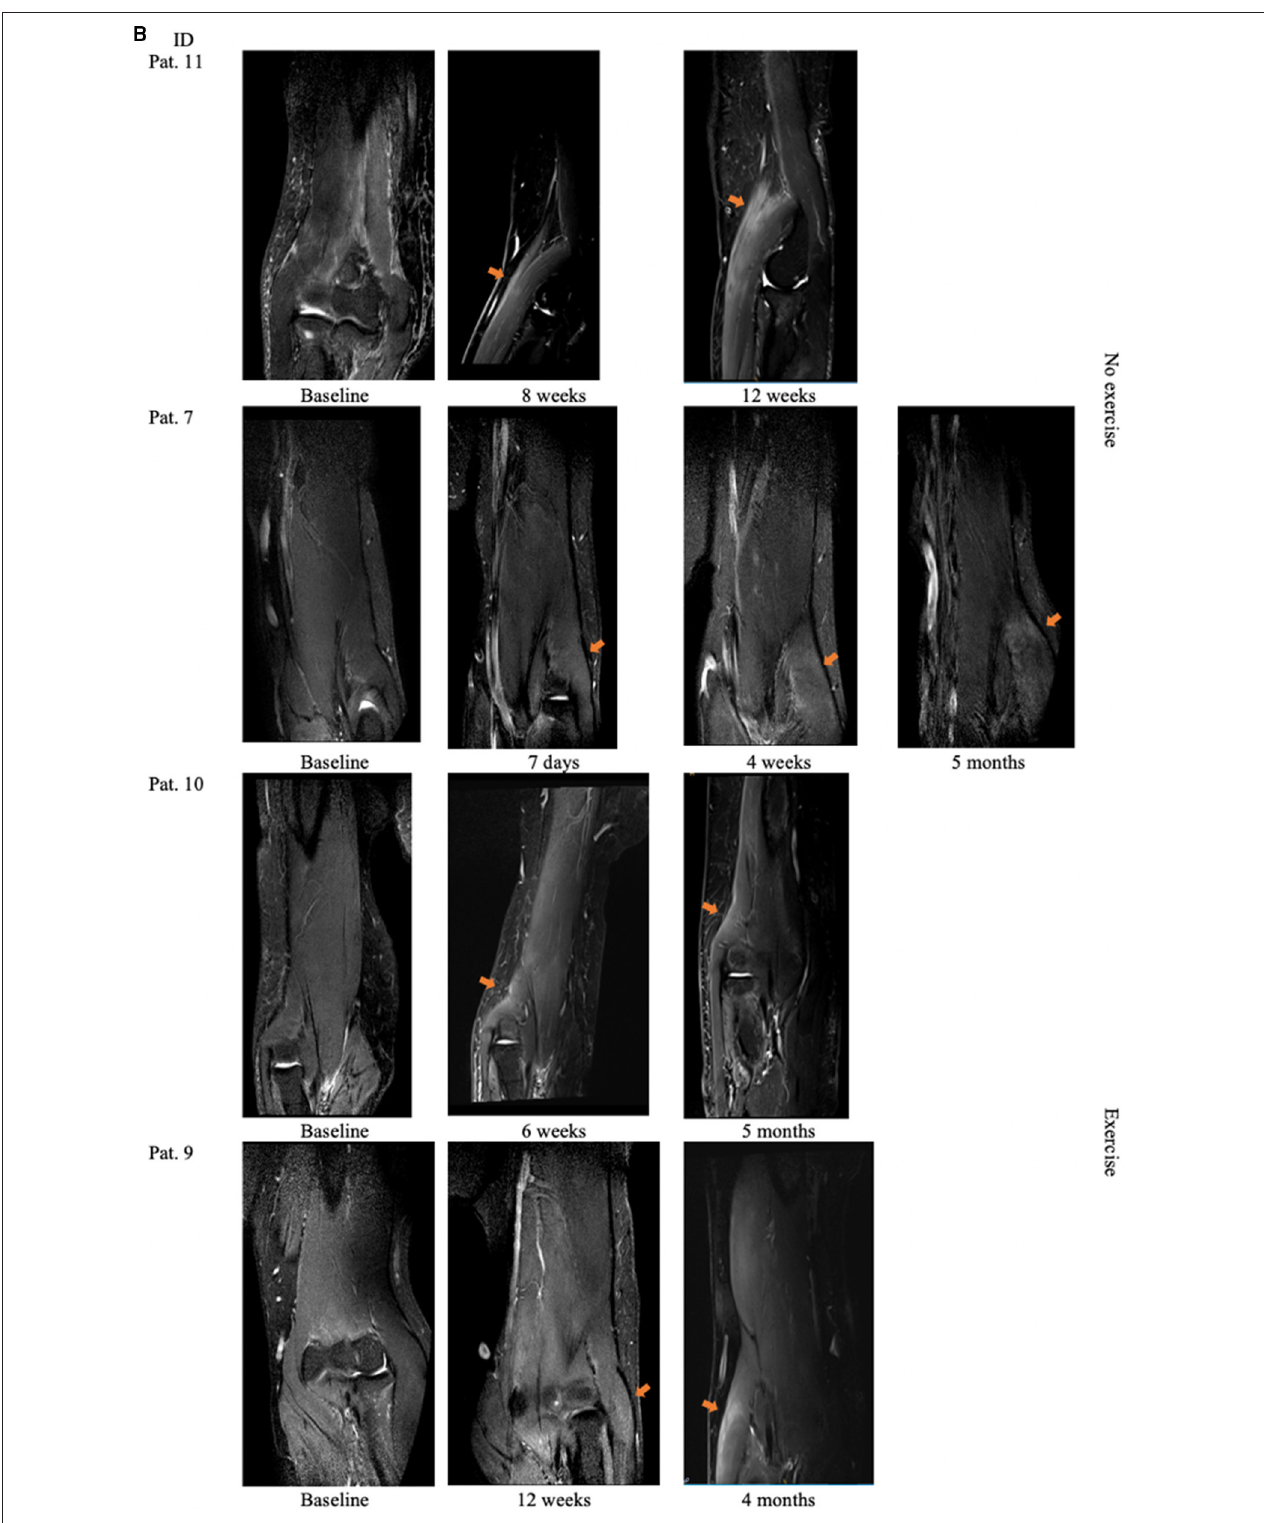
FIGURE 3 | (A) Denervation sign after intramuscular BNT injection in the MBB of patients allocated to the exercise group and no-exercise group. Pat. 2 was pretreated with BNT. arrows indicate area of denervation. (B) Denervation signs in patients M. brachioradialis .